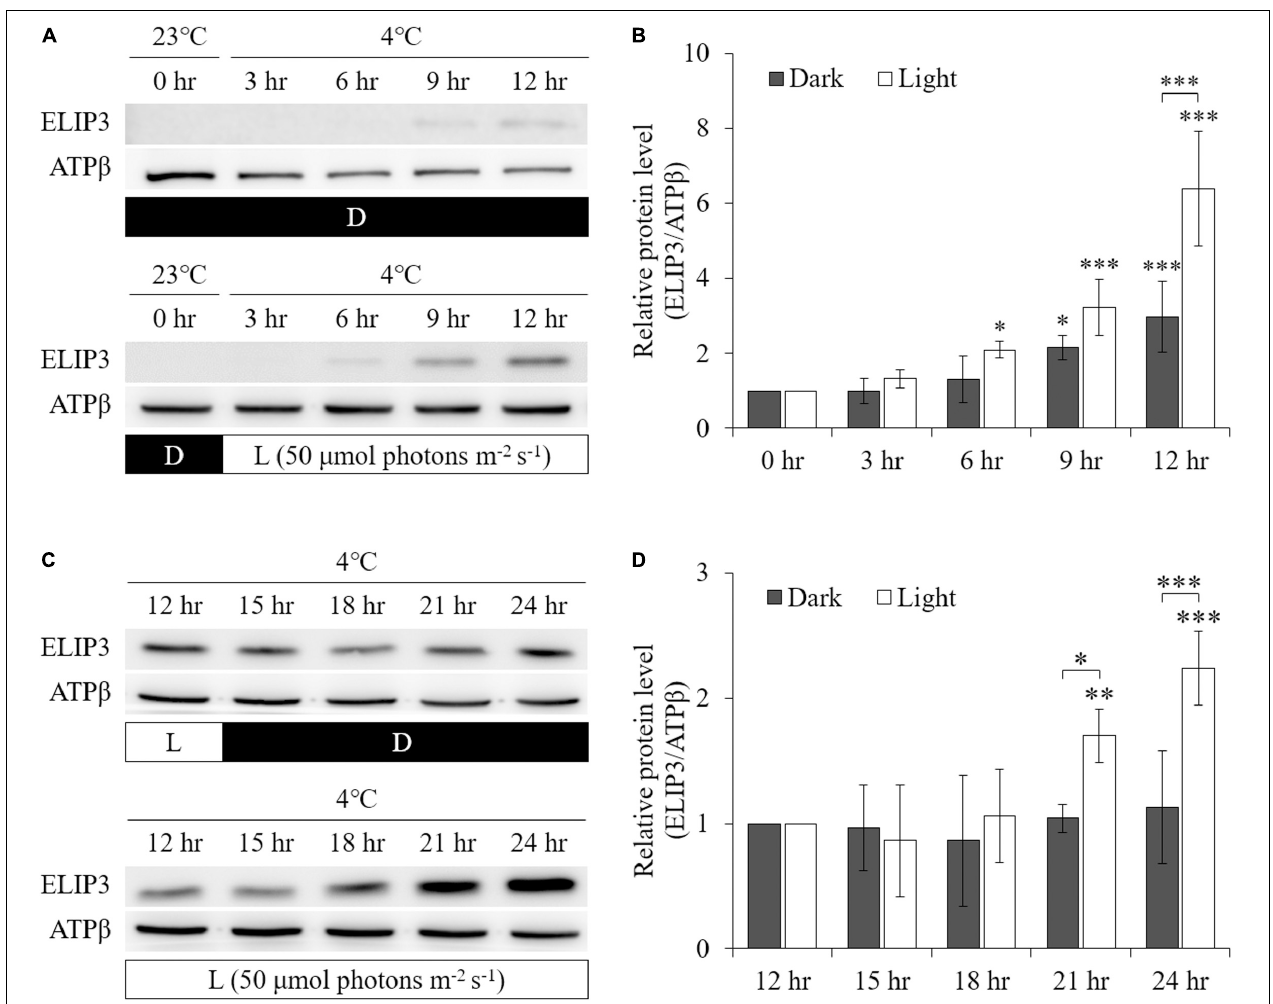
FIGURE 2 | Western blot analysis showing accumulation of ELIP3 in response to low temperature (4 ◦ C) in dark and light (50 µ mol photons m − 2 s − 1 ) conditions. (A) In dark, the accumulation started at 9 h. In light condition, the accumulation was stronger and started earlier at 6 h. (B) Densitometry of western blots in (A) . Data are expressed as mean ± SD (two-way ANOVA with Bonferroni’s multiple comparisons test, n = 3). (C) Transfer from light to dark or continuous light after 12 h of preincubation in light. Enhanced accumulation of ELIP3 in continuous exposure to light. (D) Densitometry of western blots in (C) . Data are expressed as mean ± SD (two-way ANOVA with Bonferroni’s multiple comparisons test, n = 3). ATP β was used as a loading control. ∗ P < 0.05, ∗∗ P < 0.01, ∗∗∗ P <